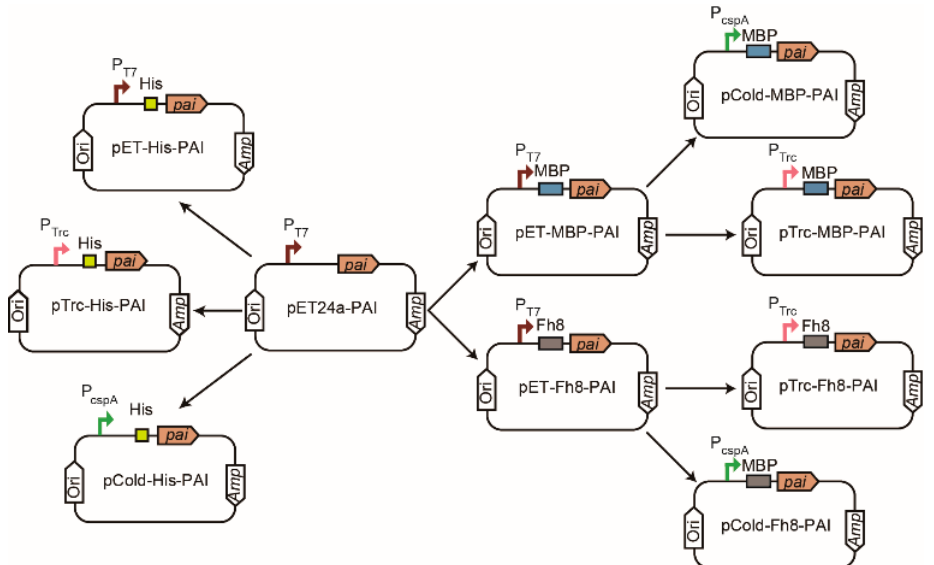
Figure 2. Construction of PAI expression vectors. PAI expression varied based on the promoters (T7, CspA, and Trc) and the fusion tags (MBP, His6, and Fh8). Table 1. Primers used for vector cloning. Underlined nucleotides refer to restriction sites or overlaps.